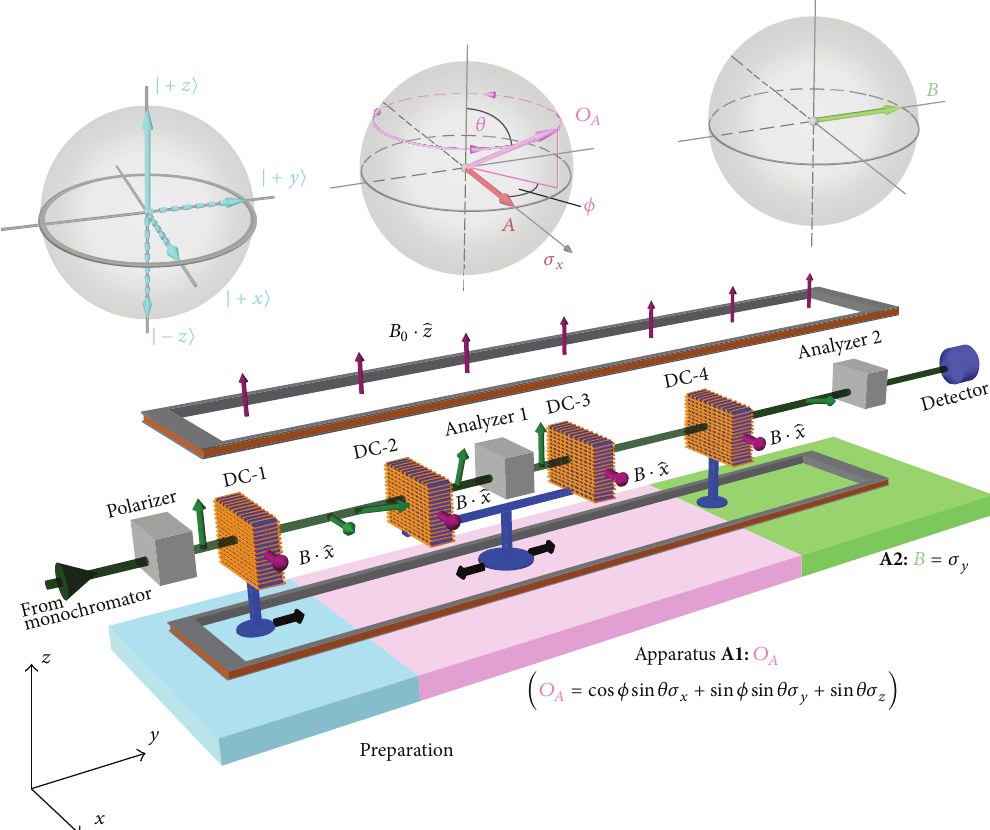
Figure 2: Neutron polarimetric setup for demonstration of the universally valid uncertainty relation for error and disturbance in neutron- spin measurements. The setup is divided into three stages: state preparation (blue region), apparatus A1 carrying out the measurement of observable 𝑂 𝐴 = ⃗𝑜 𝑎 (𝜃,𝜙) ⋅ ⃗𝜎 (red region), and apparatus A2 performing the measurement of observable 𝐵 = 𝜎 𝑦 (green region). All required terms of (5), that is, error 𝜖(𝐴) and disturbance 𝜂(𝐵) as well as the standard deviations Δ(𝐴) and Δ(𝐵) , are determined from the expectation values of the successive measurement.